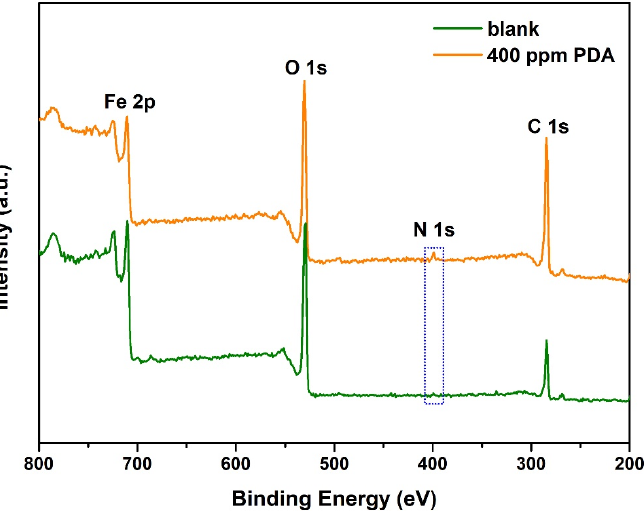
Figure 11. XPS surveys spectra for the Q235 carbon steel experiencing 60 h of exposure to 1 M HCl solution in the absence and presence of 400 ppm NCDs. Table 5. The variation of elemental composition of the steel surface after 60 h of exposure to 1 M HCl solution in the absence and presence of 400 ppm NCDs.